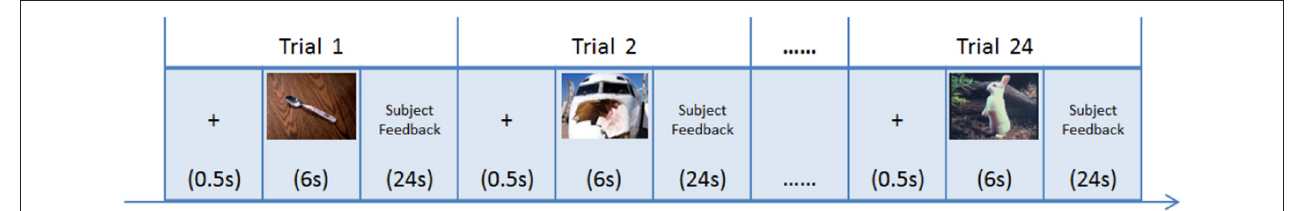
FIGURE 4 | The procedure of the assessment session. Same for both the first assessment session and second assessment